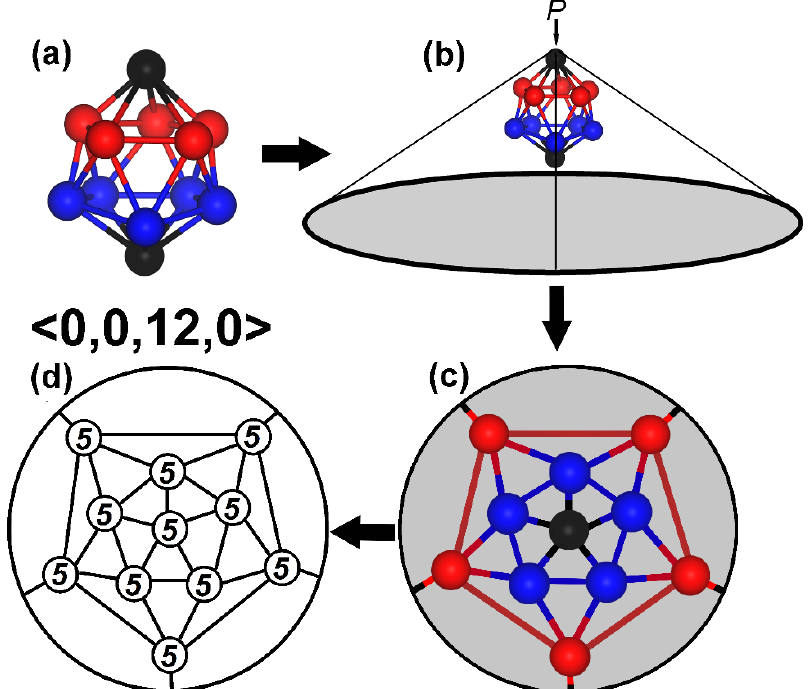
Figure 1. Schematic diagram of the projection method for reflecting the connection modes between shell atoms based on Voronoi indexed clusters. ( a ) Voronoi cluster <0,0,12,0> is selected as the studied prototype; ( b ) The shell atom on the top of cluster is projected as a disc onto the two-dimensional plane from projection pole point “P”; ( c ) The rest of the shell atoms and the connection relations are projected onto the two-dimensional plane; ( d ) The final projection plane after abstracting connection modes, and the number 5 represents the coordination number.